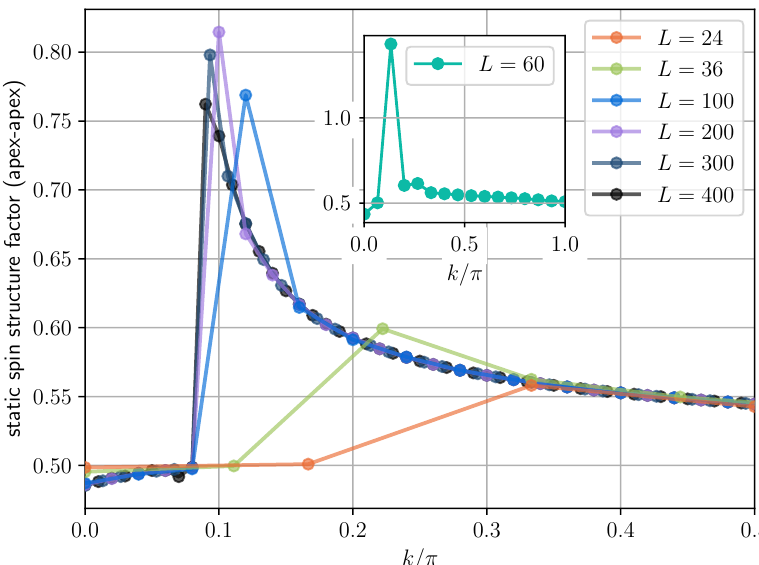
Figure 8: Static apex-apex spin-structure factor as a function of the momentum k for finite systems with periodic boundary conditions and J = − 1, J ′ = 1 (Eqs. (11) and (12) with α = β = A